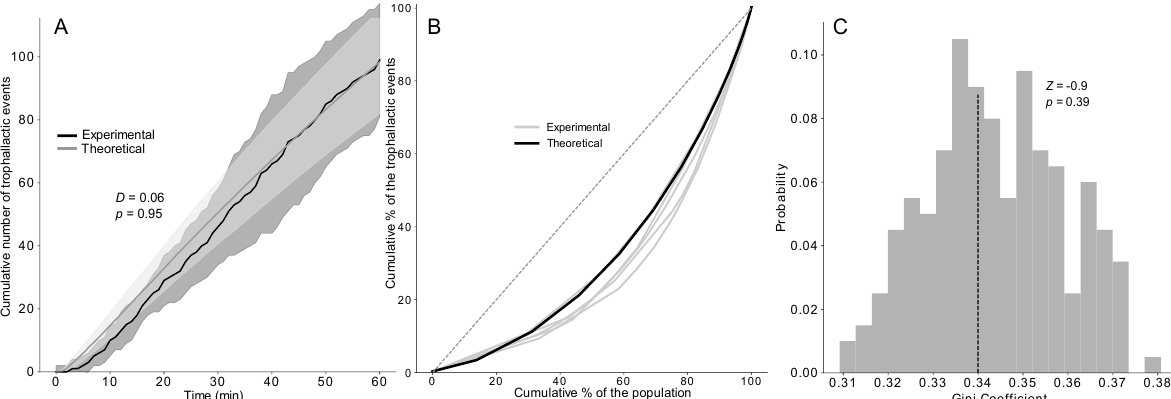
Figure 4. ( A ) Cumulative number of trophallactic events after 1 h of experiments or 3600 timesteps based on 1000 simulations of the TEC exponential model and the experiments ( n = 5) compared with a KS ( D and p- value). Dashed lines represent the time when 50% of the trophallactic events were realised, both in the model and the experiments. Shaded area = standard deviation. ( B ) Lorenz curves showing the cumulative proportions of trophallactic events (y axis) vs. the individual rank (x axis, sorted by the number of trophallactic events performed by each individual) based on the simulations (black curve, n = 1000) and the experiments (grey curves, n = 5). ( C ) Distribution of the Gini coefficients from the simulations (grey bars, n = 1000) and means from the experiments (dashed lines, n = 5), compared with a Z-test ( Z- value and p- value).